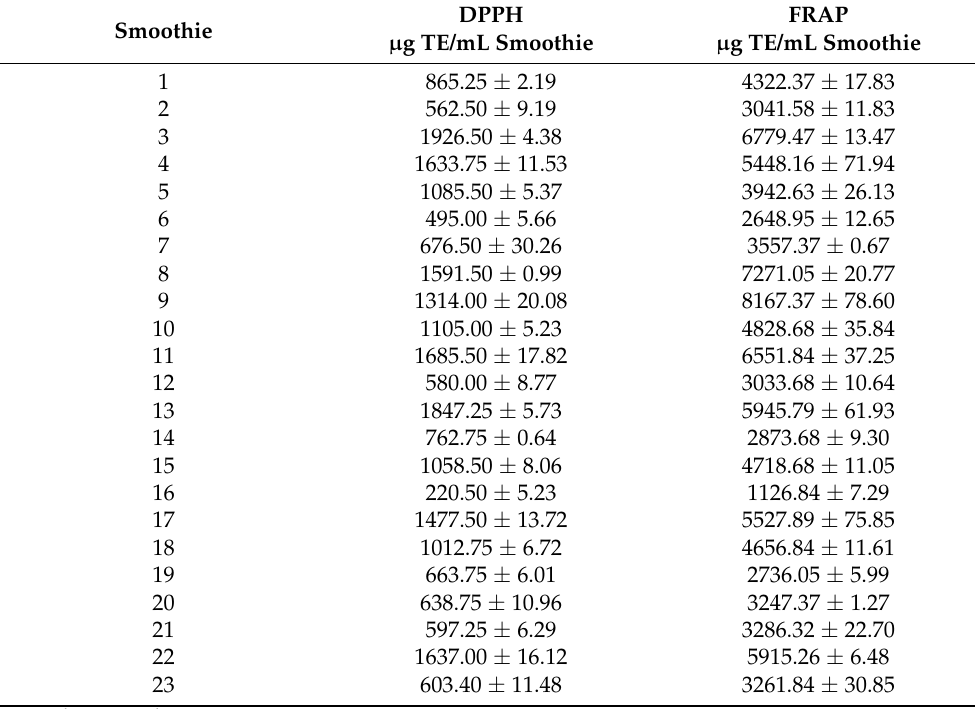
Table 5. Antioxidant activities of the smoothies expressed as average ± standard deviation.